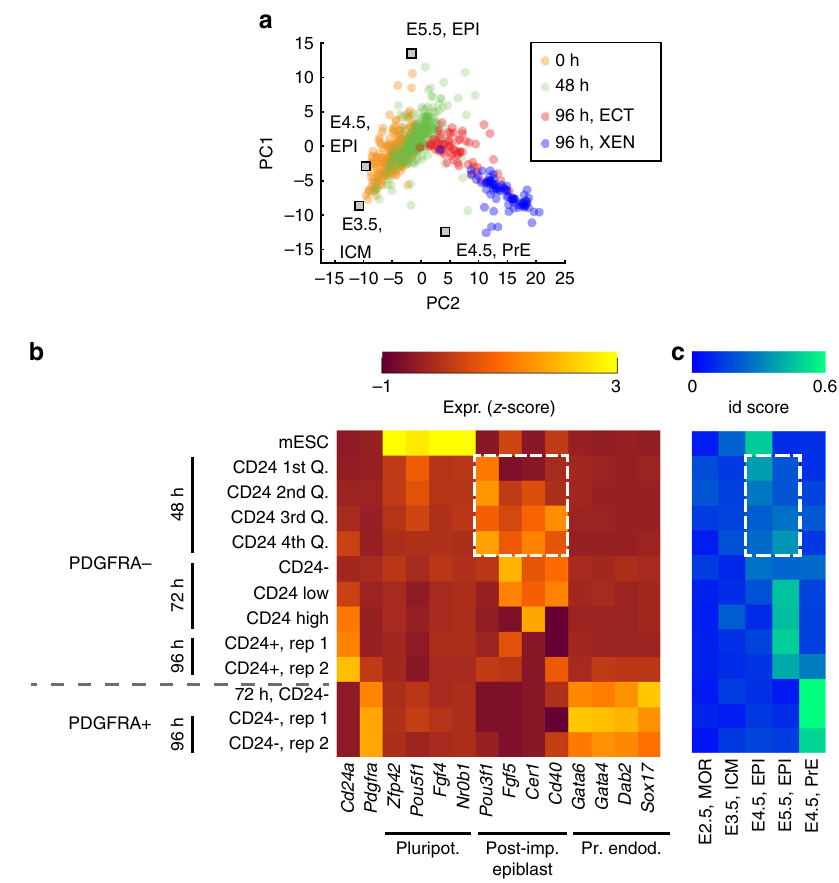
Fig. 4 Differentiation with RA differed from the pathway observed in in vivo development. a Principal component analysis of a panel of pre- / peri- implantation tissues 21 . The SCRB-seq gene expression pro fi les obtained during RA differentiation were placed in the space of the fi rst two principal components. Each data point represents an individual cell. Data points are colored according to duration of RA exposure and cell type (at 96 h). ICM: inner cell mass, EPI: epiblast, PrE: primitive endoderm. b Expression of pluripotency, post-implantation epiblast and primitive endoderm marker genes in subpopulations de fi ned by CD24 and PDGFRA expression. Cells were sorted on PDGFRA and CD24 antibody staining by FACS before RNA extraction at the indicated periods of RA exposure (48 h, 72 h and 96 h) and bulk RNA-seq. At 48 h, PDGFRA- cells were sorted by quartiles of CD24 expression, at 72 h cells were sorted by PDGFRA expression and terciles of CD24 expression. Expression of post-implantation epiblast markers at 48 h is highlighted with a dashed white box. c Identity of bulk RNA-seq samples as determined by the KeyGenes algorithm 23 . A panel of pre- / peri-implantation tissues 21 was used as the training set. A high identity (id) score corresponds to a high con fi dence about tissue identity. (MOR: morula, ICM: inner cell mass, EPI: epiblast, PrE: primitive endoderm). The identity scores for the epiblast tissues at 48 h are highlighted by a white dashed